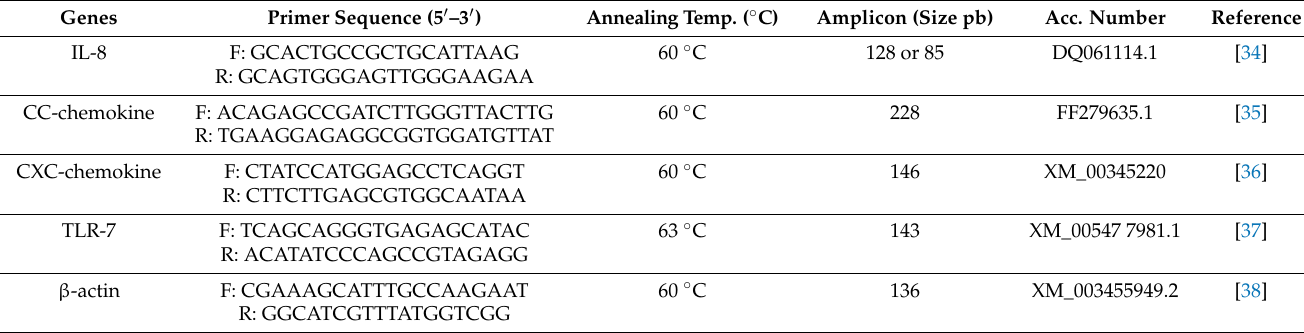
Table 1. Sequences of primers used in real time PCR.